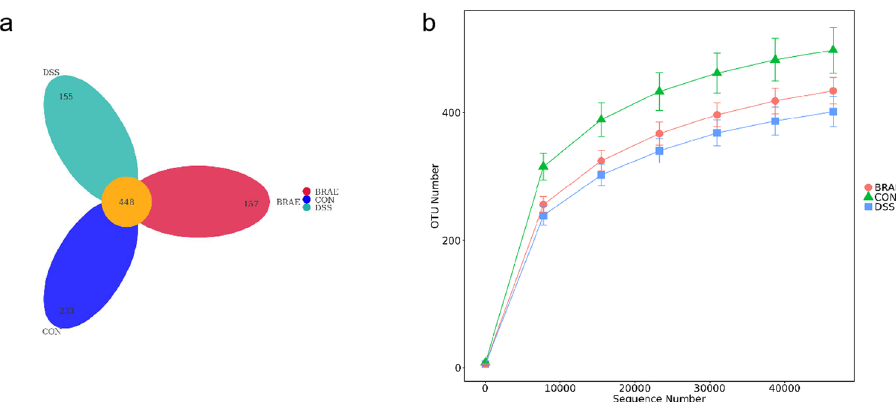
Figure 8: BRAE inhibited DSS - induced decrease of gut microbiota diversity in mice. ( a ) OTU petal diagram, the petal part is OTU unique to each group, and the fl ower center is the OTU shared by all samples; ( b ) sample sparsity curve.